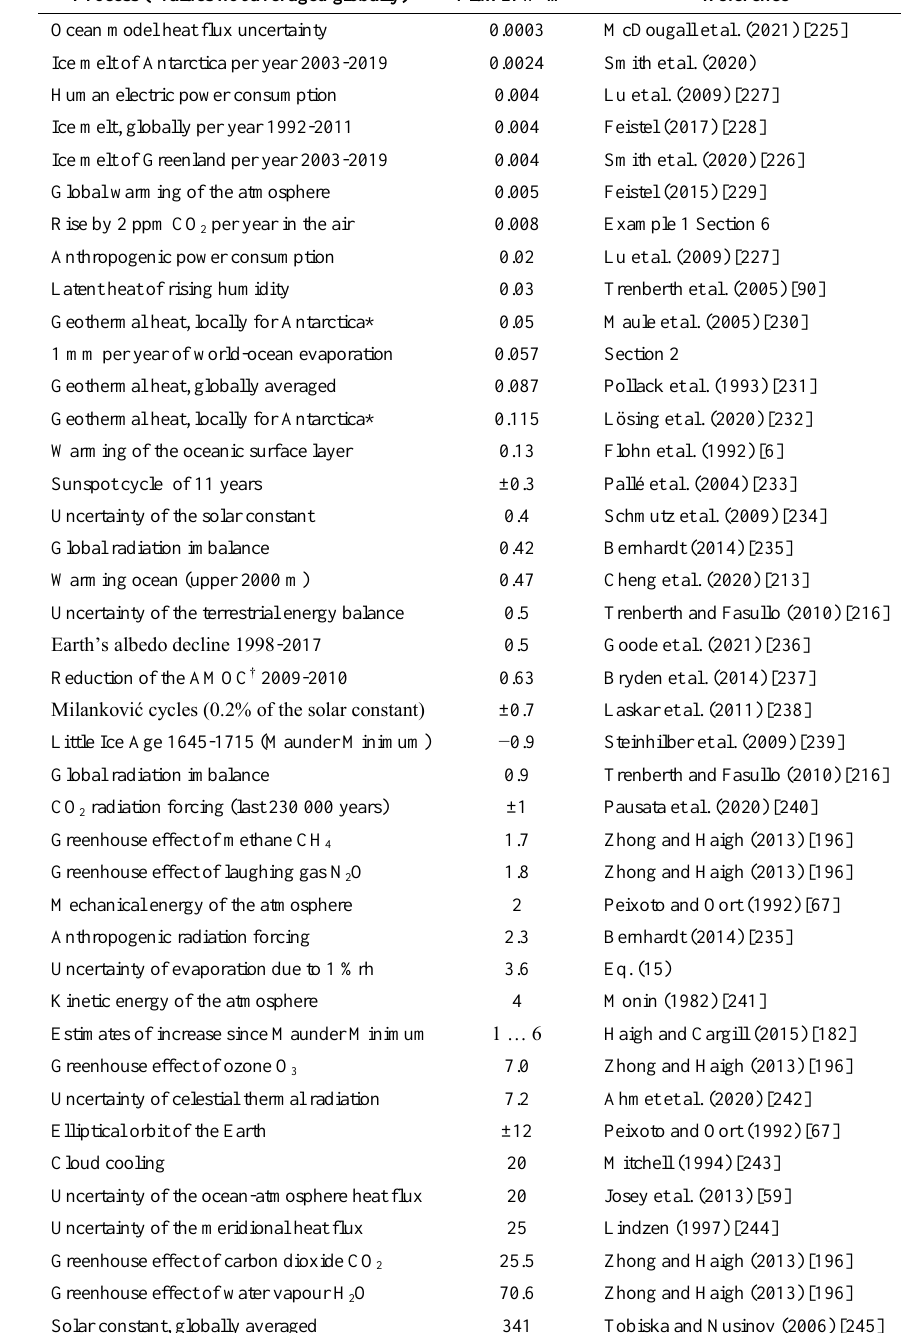
Table 2. Estimates of globally averaged energy forcings * of selected processes, see also Hupfer (1991) [246] Process (*values not averaged